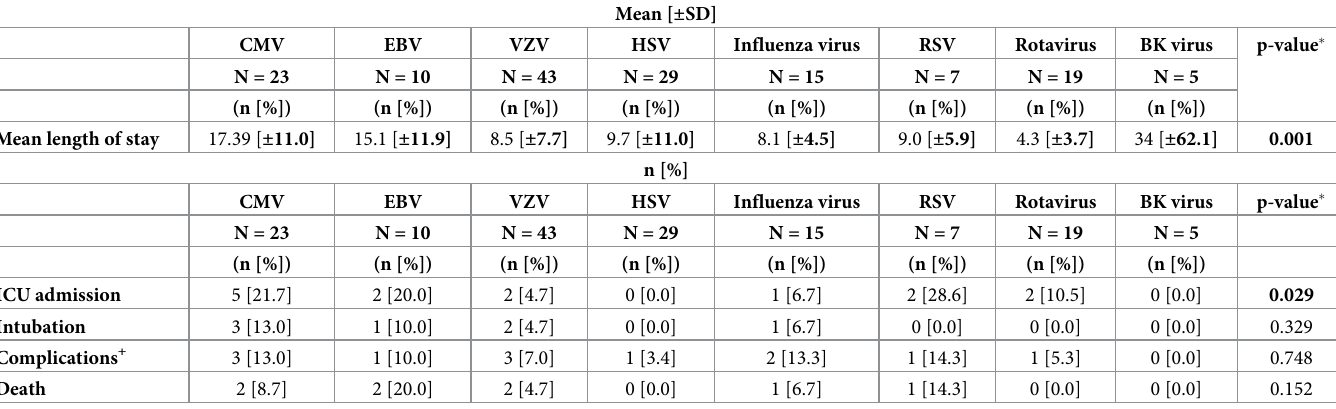
Table 5. Clinical outcomes of viral infections in children and adolescents with